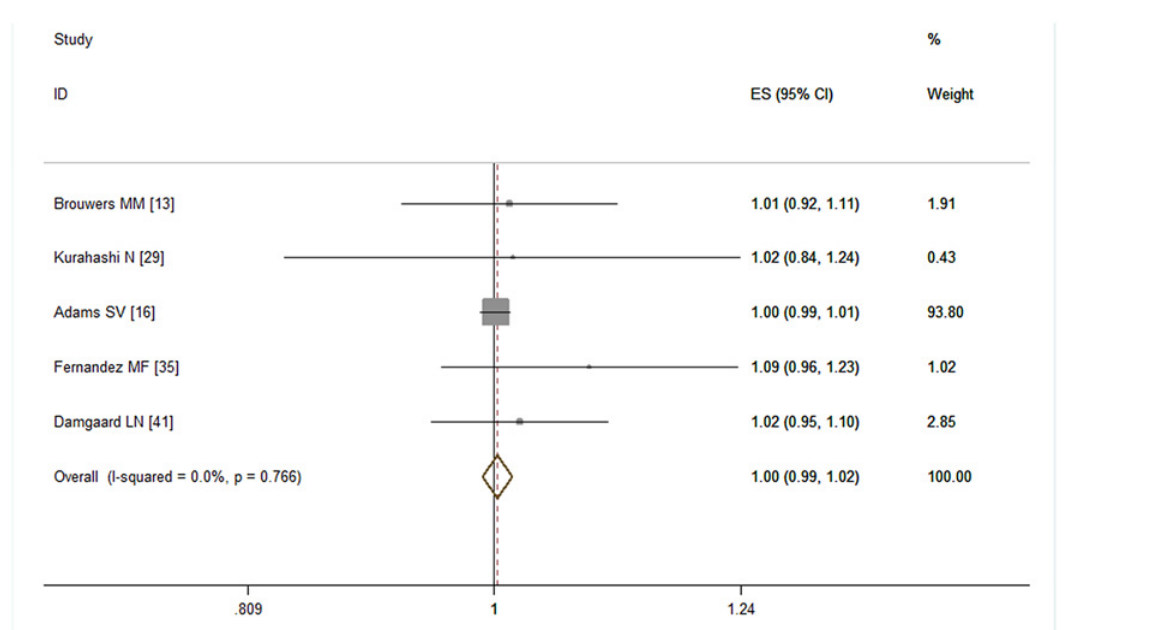
Fig 7. Forest plot for each 5 kg /m 2 increase of BMI and risk of cryptorchidism.